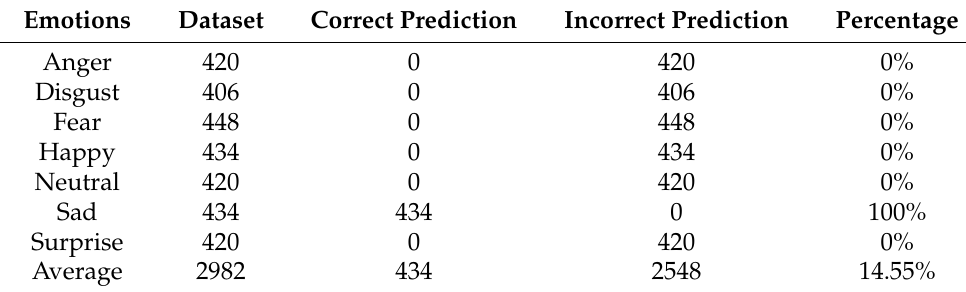
Table 24. Cross dataset testing result of Model 2 after 100